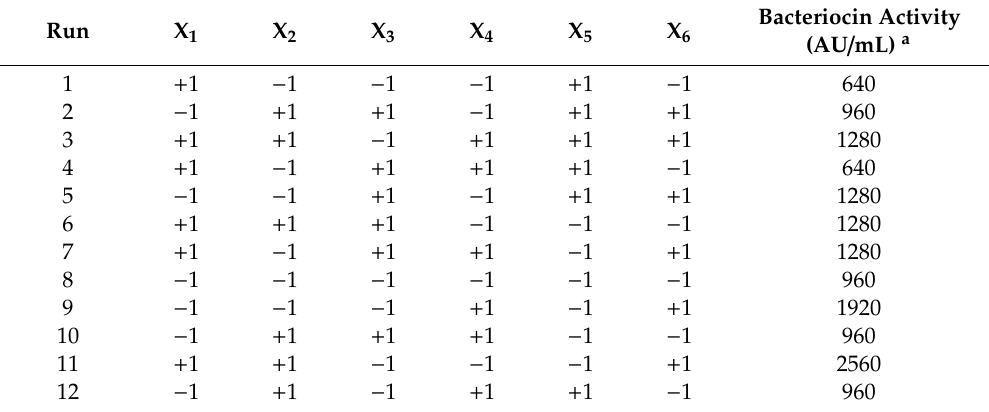
Table 4. Plackett-Burman experiment design and response values.